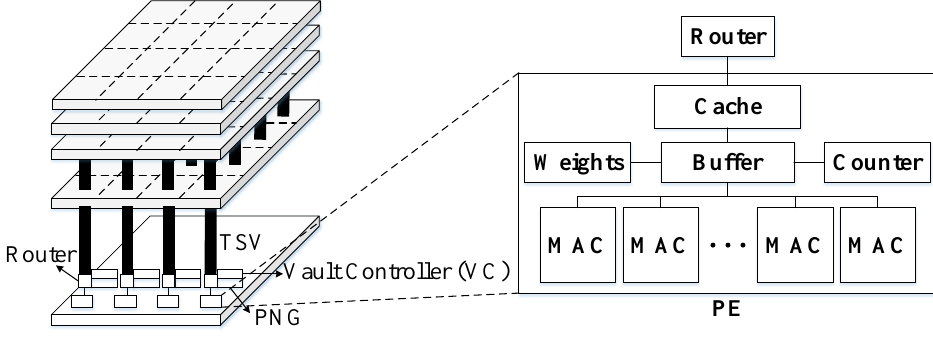
Figure 16. Overview of the Neurocube architecture and organization of a PE (adapted from